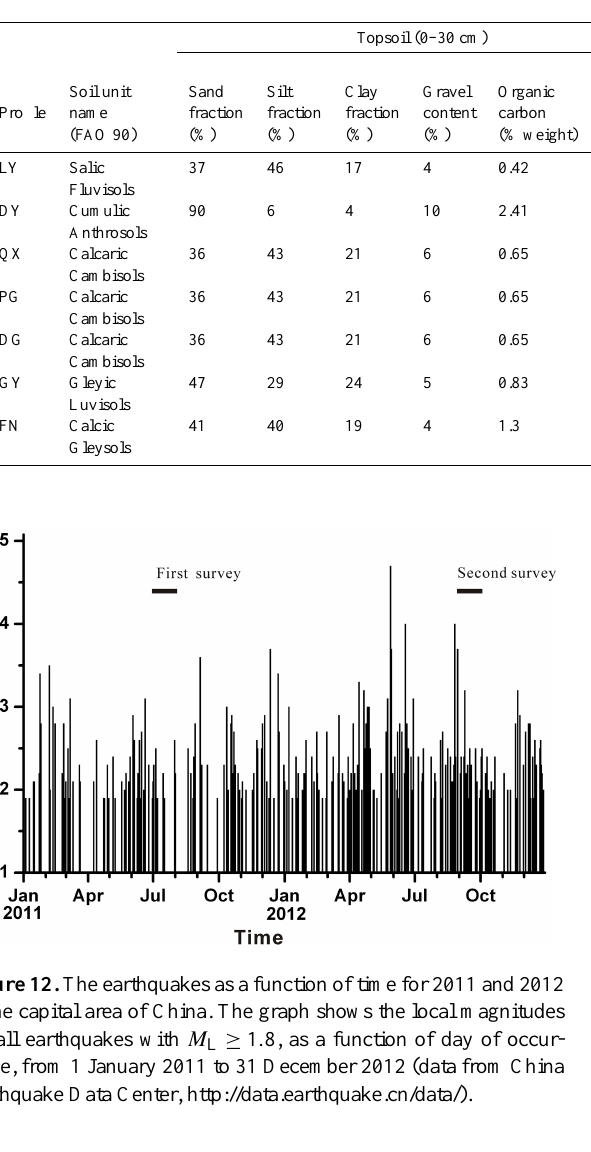
Table 1. Component percentages in soil in the study areas (FAO/IIASA/ISRIC/ISSCAS/JRC, 2012).